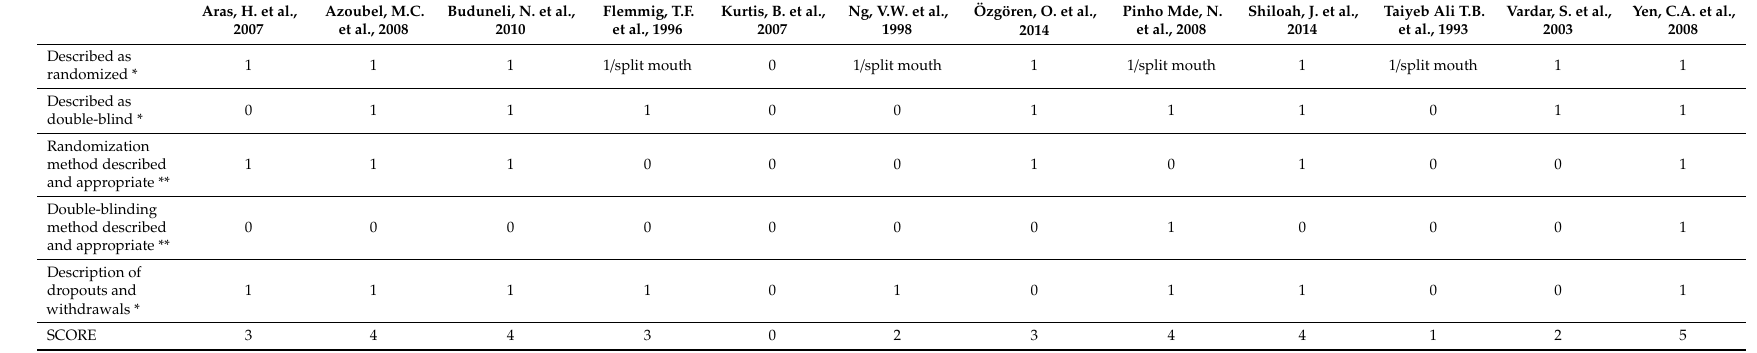
Table A3. Quality assessment via the Oxford quality scoring